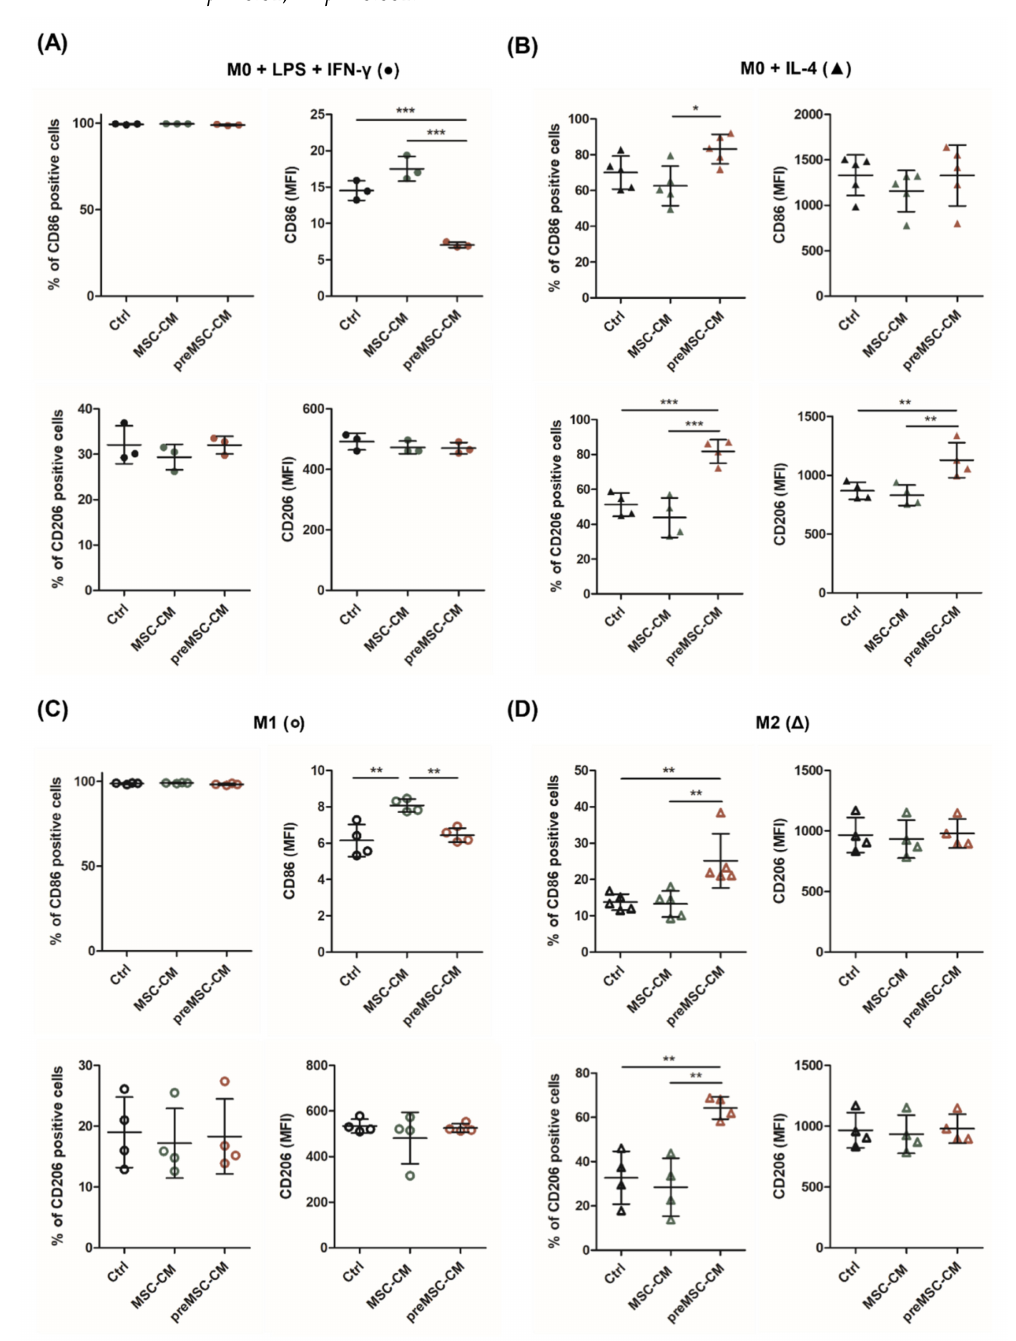
Figure 3. Effect of MSC-CM and preMSC-CM on the macrophage markers CD86 and CD206. Surface expression of CD86 and CD206 on macrophages cultured under ( A ) M1- and ( B ) M2a-polarizing culture conditions and 20% (pre)MSC-CMs was determined by flow cytometry. In addition, protein expression on polarized M1 ( C ) and M2 ( D ) macrophages was determined. Cells cultured in the absence of (pre)MSC-CM served as control (Ctrl). ( n = 3–5). * p < 0.05; ** p < 0.01; *** p <